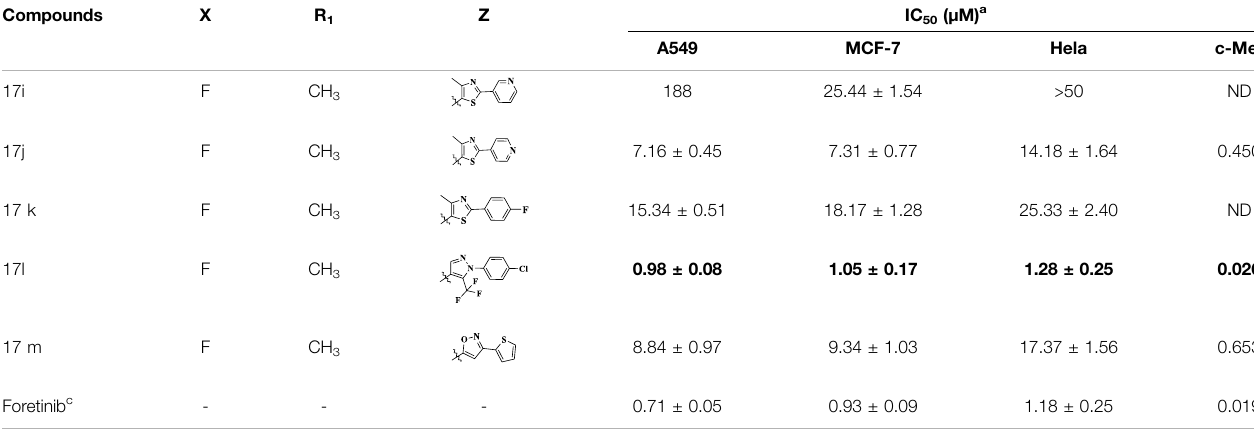
TABLE 1 | ( Continued ) Antiproliferative and mesenchymal – epithelial transition factor (c-Met) kinase inhibitory activities of the target compounds. Compounds